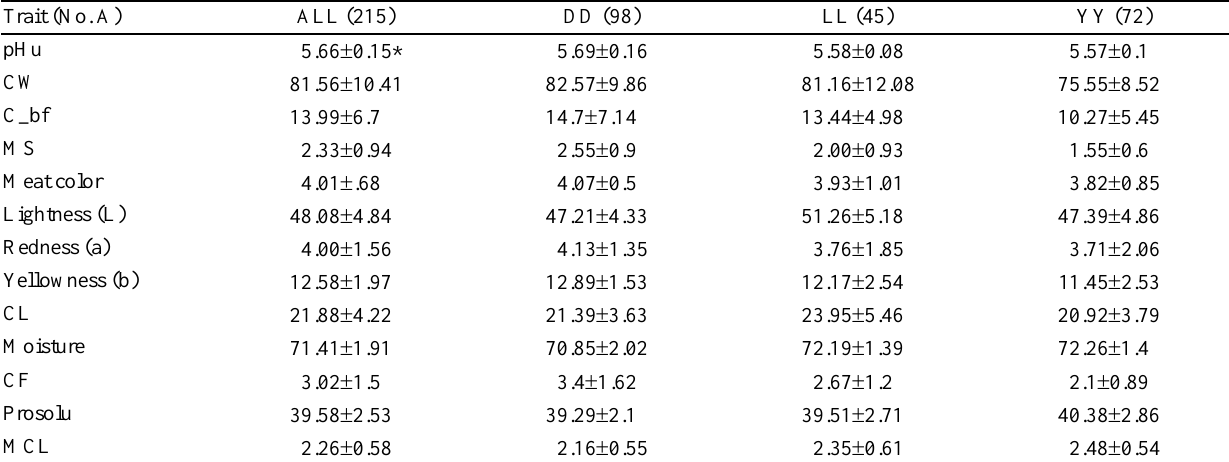
Table 1. Summary statistics of the characteristics of musculuslongissimus lumborum et thoracis meat samples Trait (No. A)